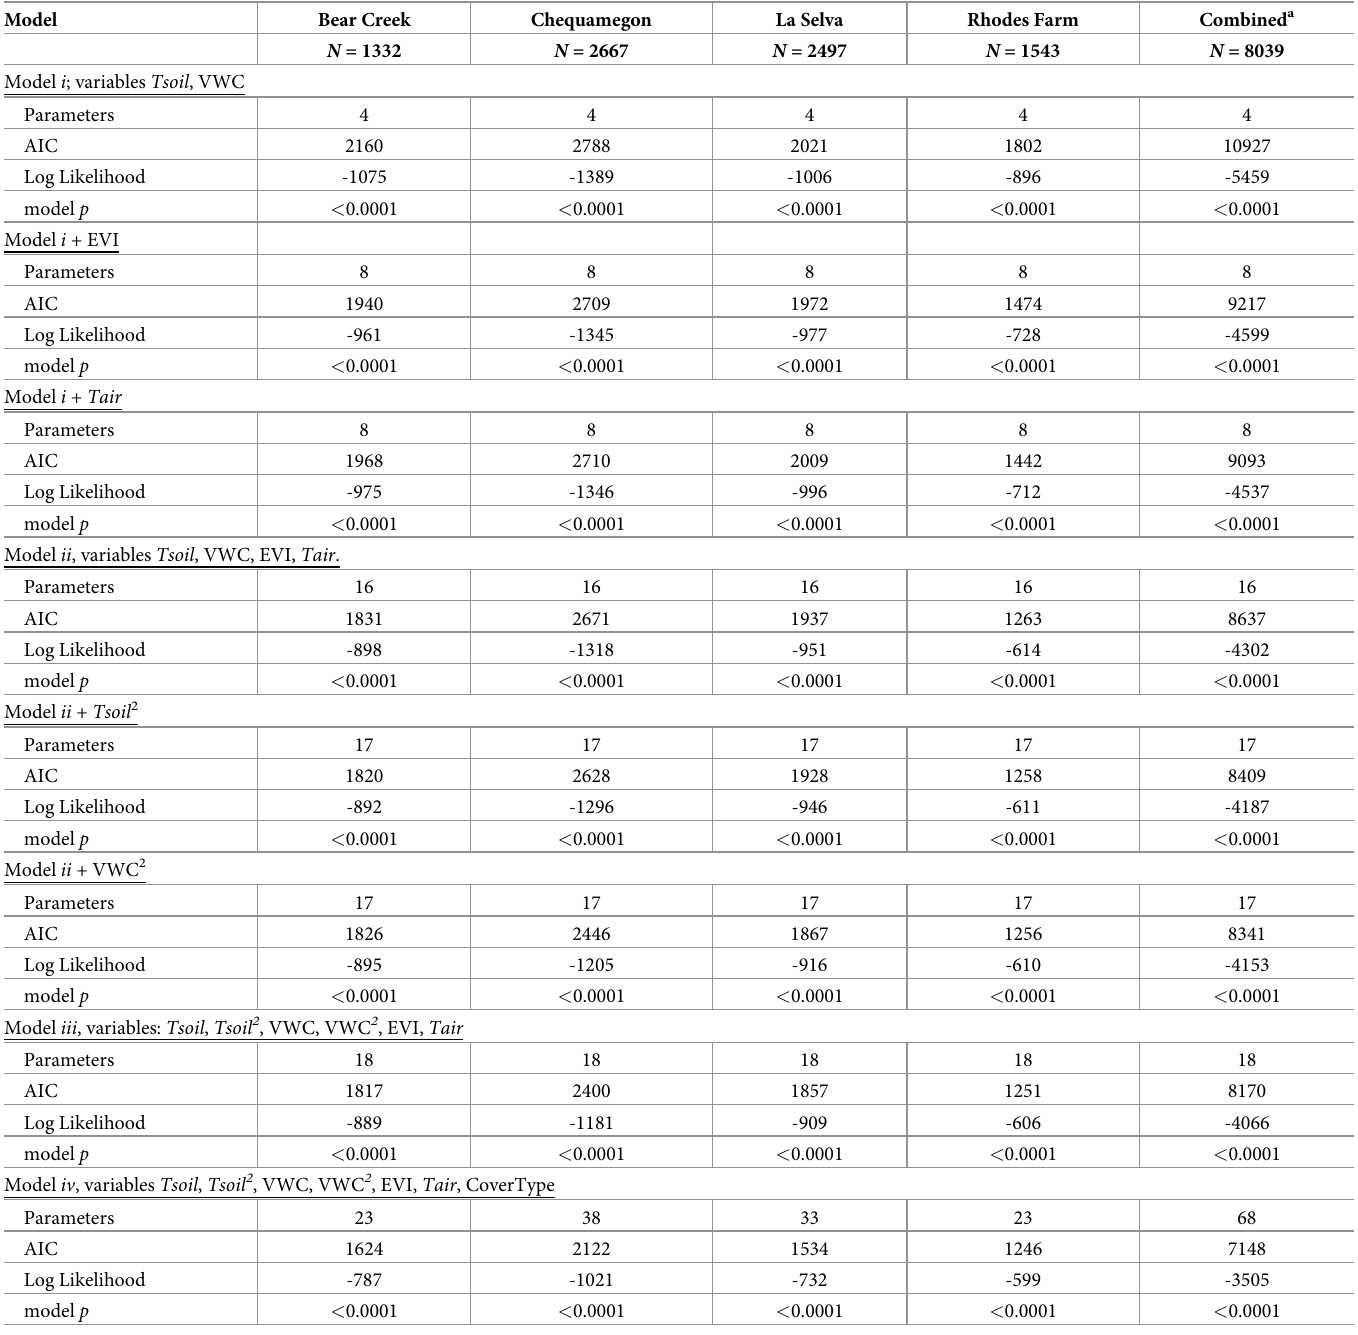
Table 3. Summary results of models fitted to data from four